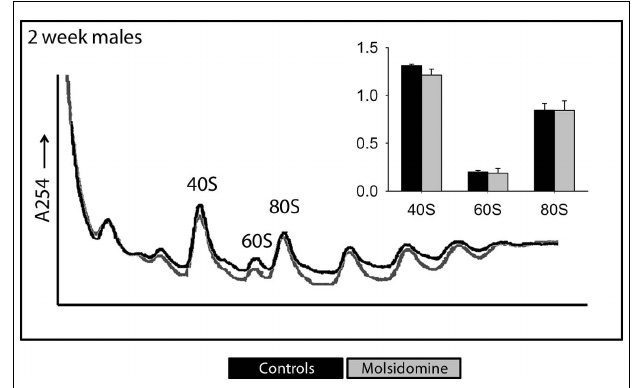
FIGURE 5 | Polysome profiles of livers. Livers from 2-week-old FHH males were profiled to measure the total number of assembled ribosome structures.The peaks of 40S, 60S, and 80S were normalized against the left-most peak and the results shown in the corresponding histograms. Black and gray lines are from the control and molsidomine groups, respectively.